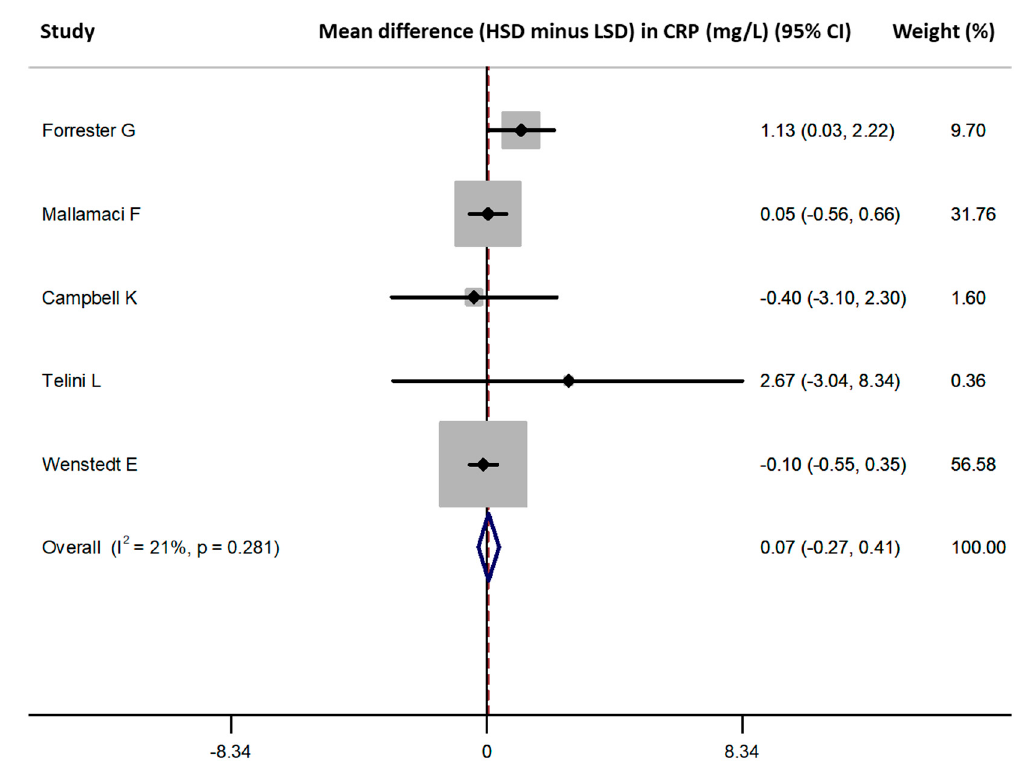
Figure 3. Forest plot of the mean difference in CRP levels for high sodium dose (HSD) versus low sodium dose (LSD), as defined per study [27,37,38,41,42].